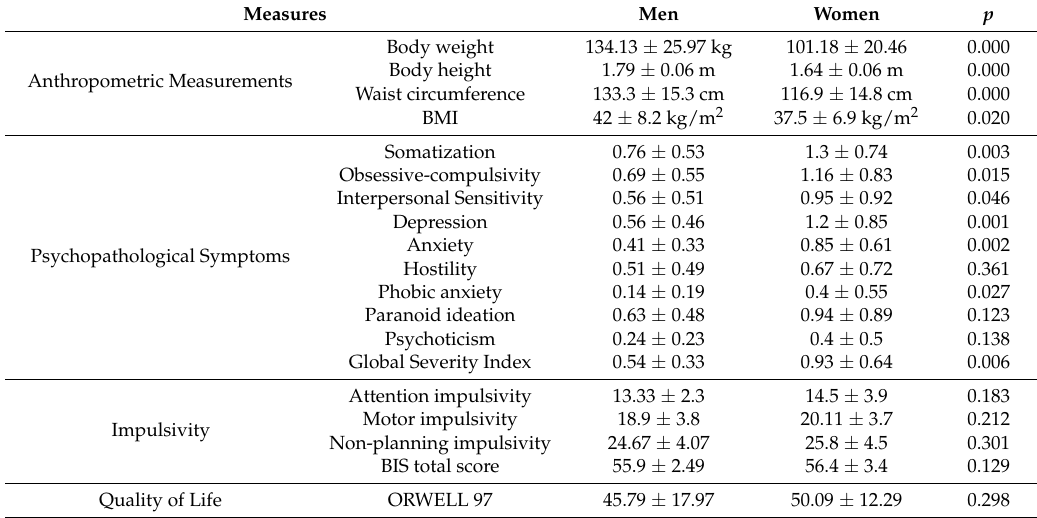
Table 1. Mean and standard deviations of anthropometric and psychological measurements, differentiated on the basis of gender. BIS: Barratt Impulsiveness Scale; BMI: body mass index; ORWELL 97: Obesity-Related Well-Being questionnaire.